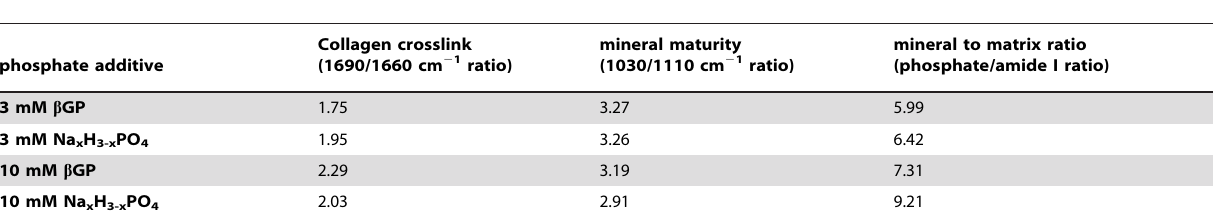
Table 1. Matrix and mineral characteristics derived from FT-IR data.